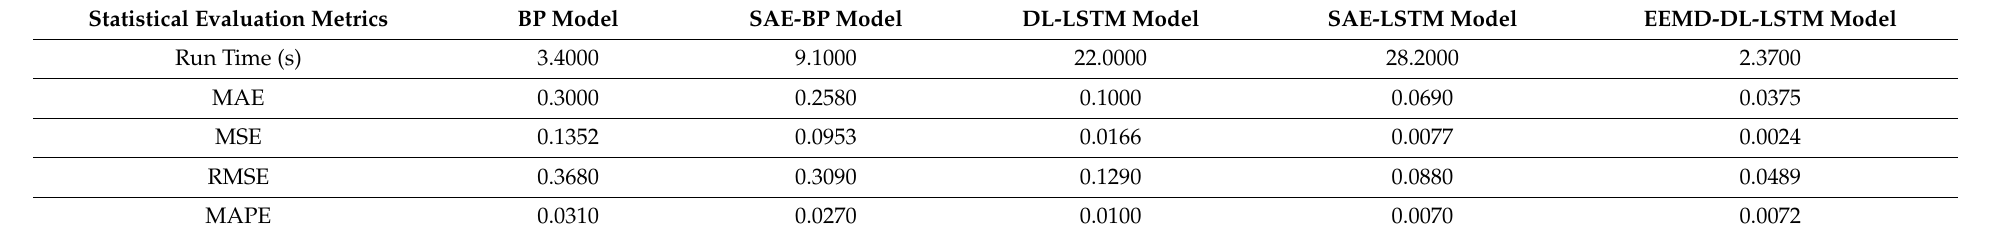
Table 3. Comparison of prediction accuracy and run time (s) against similar models *. Statistical Evaluation